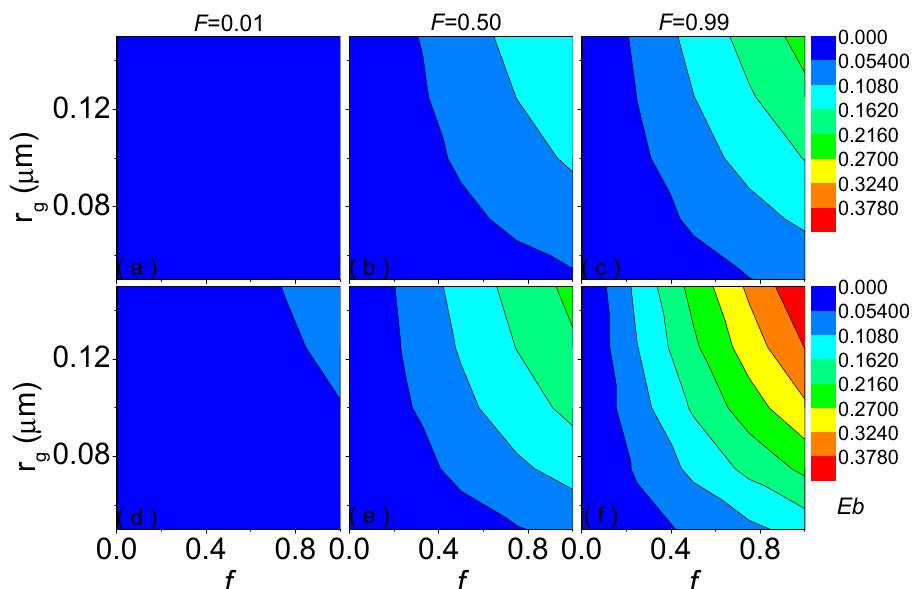
Figure 6. Absorption enhancement of BC reduced by of the blocking effect of the absorbing coating ( E b ) with different coating absorbing volume fractions ( f ) and size distributions. Increasing coated volume fractions of BC (0.01, 0.50, and 0.99) are shown from left to right. Two shell/core ratios of 1.5 ( top ) and 2.7 ( bottom ) are considered. Geometric standard deviations ( σ g ) for applied log-normal distributions are 1.59.